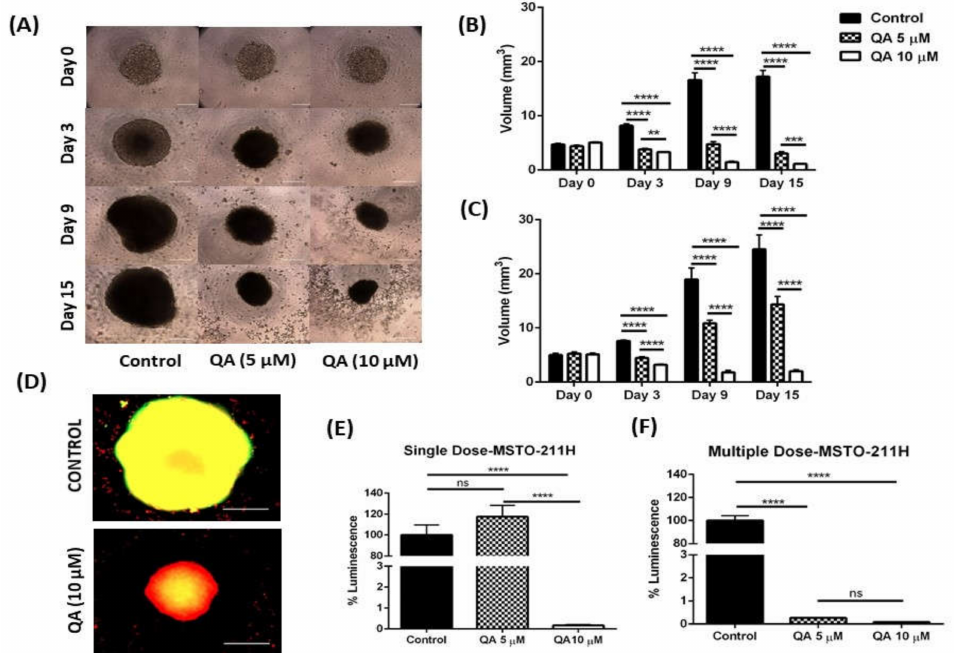
Figure 4. Three-dimensional-spheroid cell culture study for QA in MSTO-211H cell line. ( A ) Represent spheroids from multiple dose regimen for MSTO-211H cells, representing day 0, 3, 9, and 15. It can be clearly seen that increase in concentration of QA (5- and 10 µ M) and exposure time, inhibition of spheroid growth is increased. MSTO-211H spheroids show a huge di ff erence in the spheroid size over 15 days, with control spheroids reaching sizes as big as 25 mm 3 in volume, whereas treated spheroids are as small as 1 mm 3 . ( B ) Plots represent spheroid volumes plotted for multiple dose and ( C ) single dose treatments for both cell lines. A significant di ff erence can be seen in almost all treatment groups and control for all 3 days and both dosing regimens. ( D ) Representation of Live / Dead cells in the spheroid mass. Live cells are stained green and dead cells are stained red using a live / dead cell assay kit. It can be clearly seen that QA-treated spheroids have more dead cells than untreated spheroids, indicating excellent potency. ( E , F ) Plots represent cell viability of MSTO-211H spheroids after both single and multiple dosing regimen. Data represents mean ± SEM ( n = 6) for volume and mean ± SD ( n = 3) for viability analysis, ** p < 0.01, *** p < 0.001, **** p < 0.0001, compared between treatment and control groups, as indicated, Scale bar 1000 µ